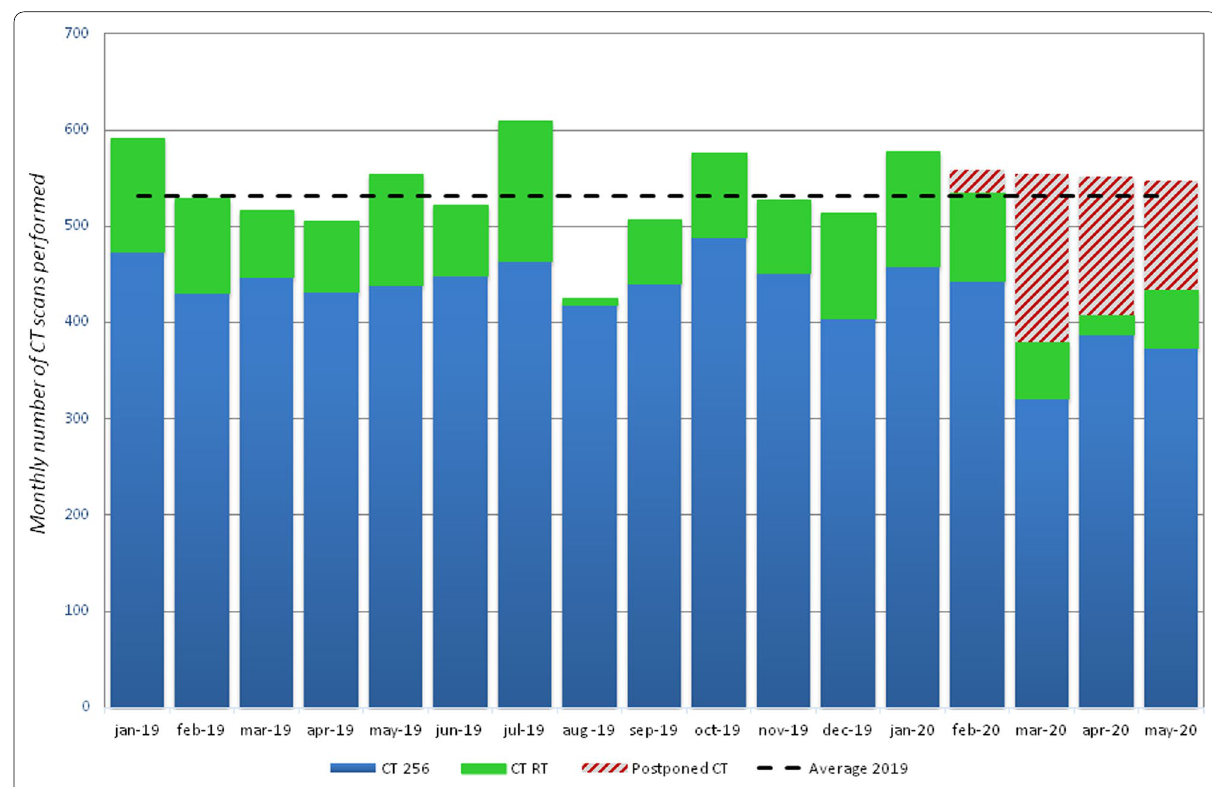
Fig. 2 The bar chart represents the monthly number of CT examinations performed from January 2019 to May 2020 for the two CTs available in our facility (CT 256 and CT RT). The black dashed line refers to the average data for 2019. The black dashed line represents the rescheduled CTs from the end of February 2020 and during lockdown with respect to the originally planned